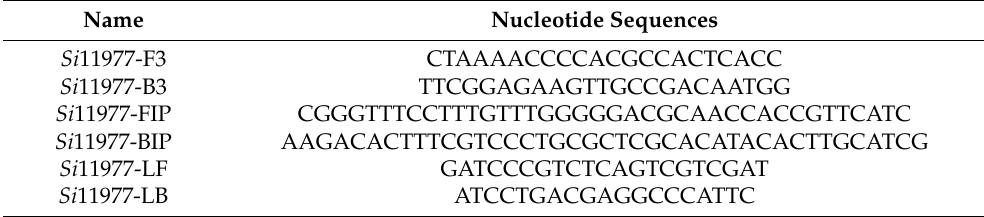
Table 1. Oligonucleotide sequences of six primers for the Si 11977 LAMP